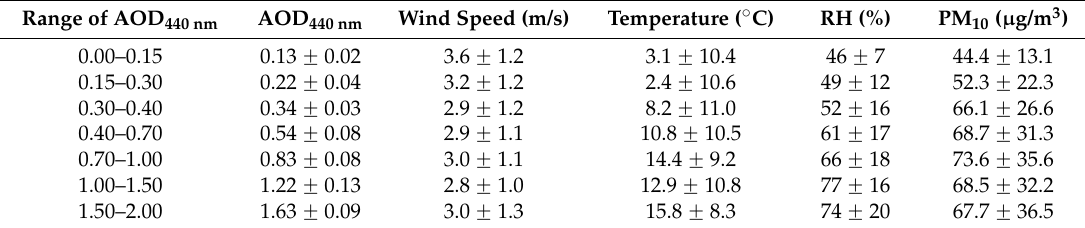
Table 2. The average values of AOD 440 nm and meteorological parameters within different ranges of AOD 440 nm .